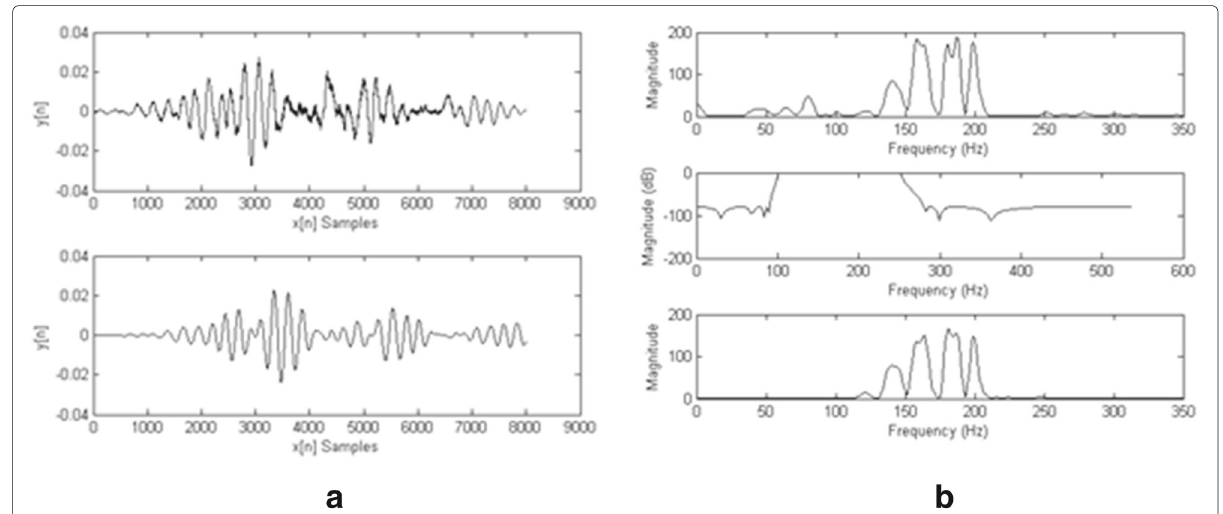
Fig. 6 Signal analysis in frequency domain. a Signal before and after filtering. b Signal spectrum before and after